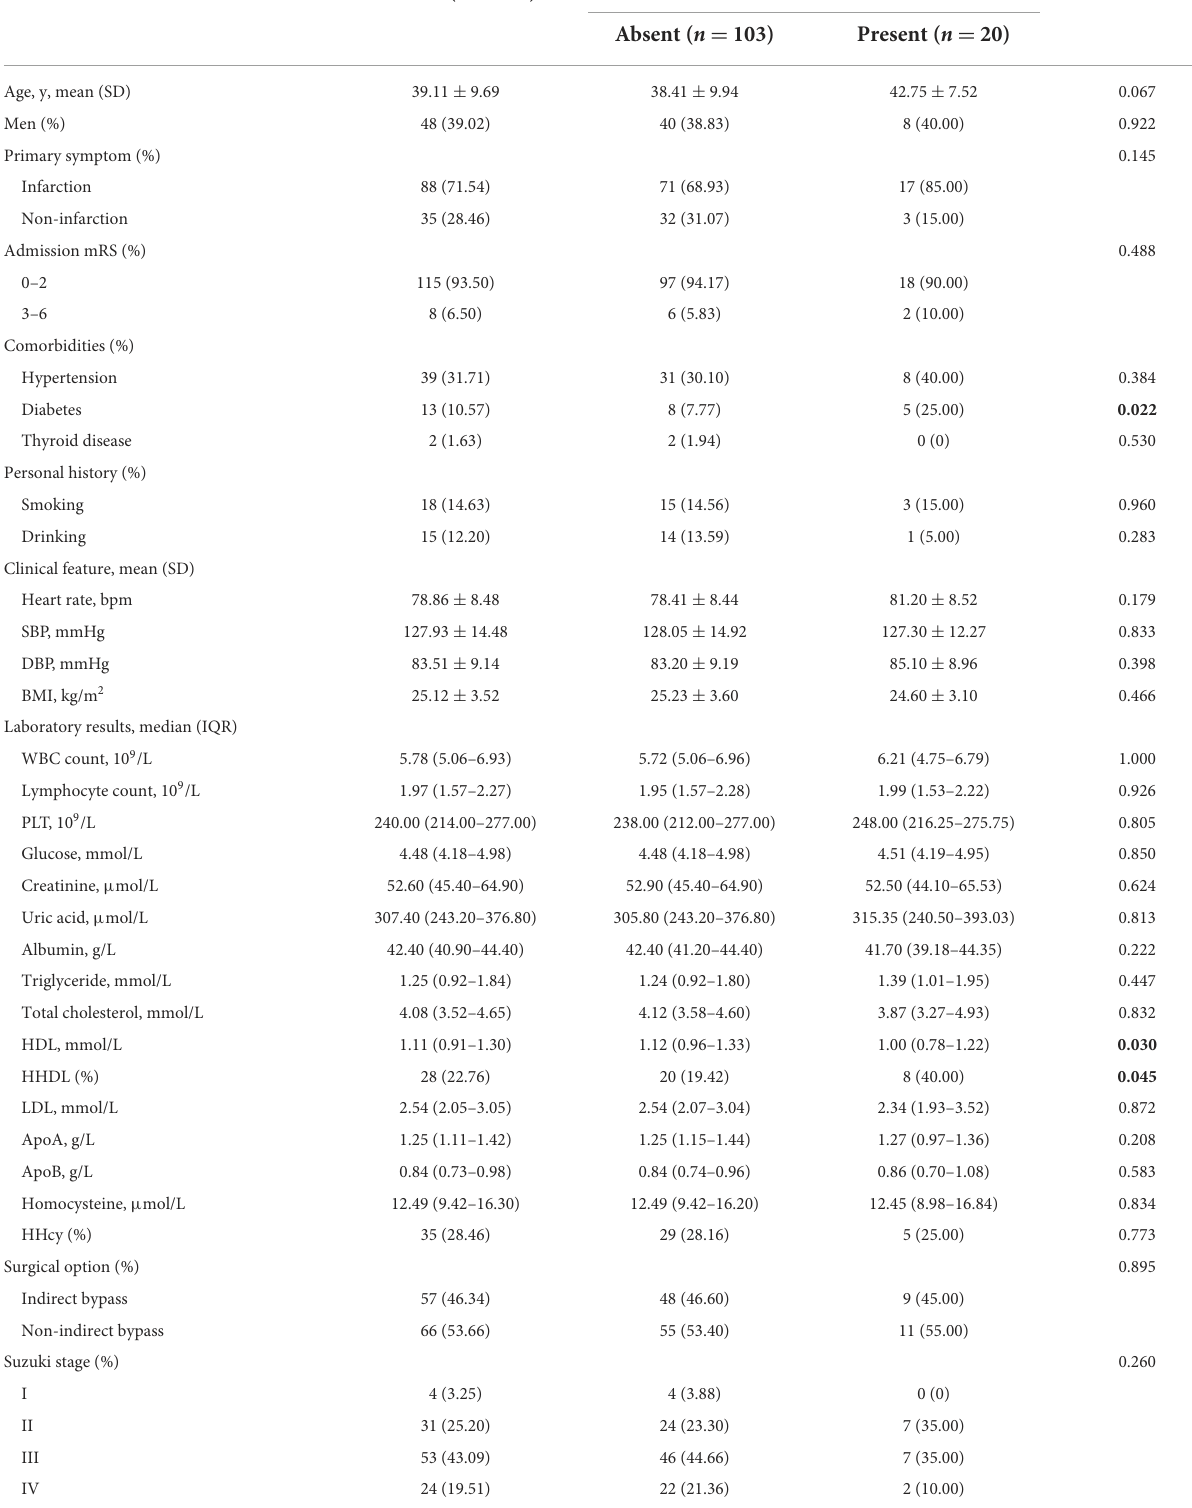
TABLE 1 Baseline characteristics of the participants with and without recurrent